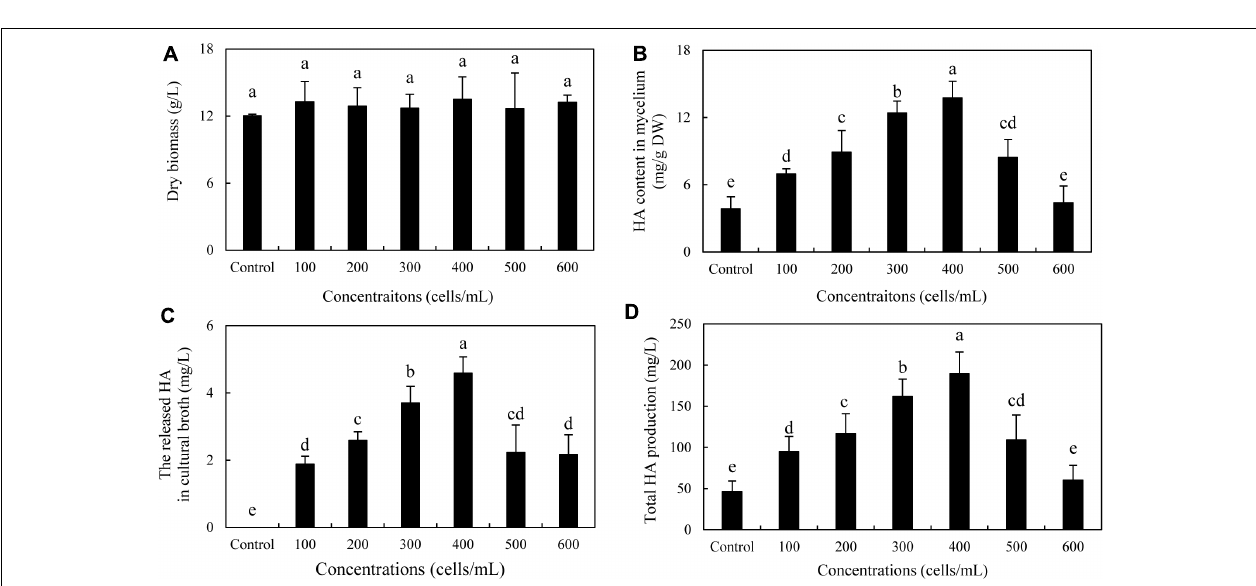
FIGURE 7 | The effect of live bacteria on the expression of Shiraia HA biosynthetic genes. The bacteria SB1 and No. 1 at 100 cells/ml were added to the cultures on day 4 for 24 h, respectively. PKS , polyketide synthase; Omef , O -methyltransferase; Mono , monooxygenase; MCO , multicopper oxidase; FAD , FAD/FMN-dependent oxidoreductase; ZFIF , zinc finger transcription factor; MFS , major facilitator superfamily; ABC , ATP-binding cassette transporter. Values are mean ± SD from three independent experiments. ∗ p < 0.05, ∗∗ p < 0.01 versus control group.